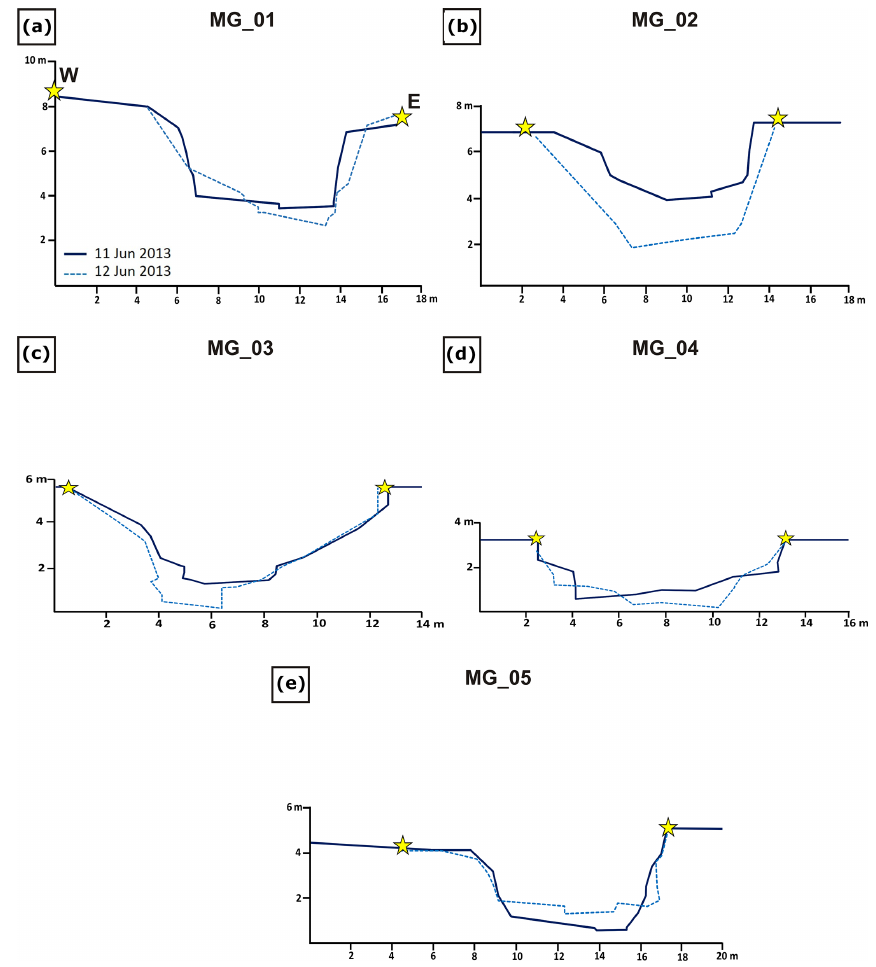
Figure 4. Cross-section profiles before (bold blue lines) and after (hatched lines in light-blue) the 11 June 2013 lahar for the following checkpoints (Fig. 1 for location): (a) MG_01, (b) MG_02, (c) MG_03, (d) MG_04, (e) MG_05. All the profiles were taken facing upstream of the